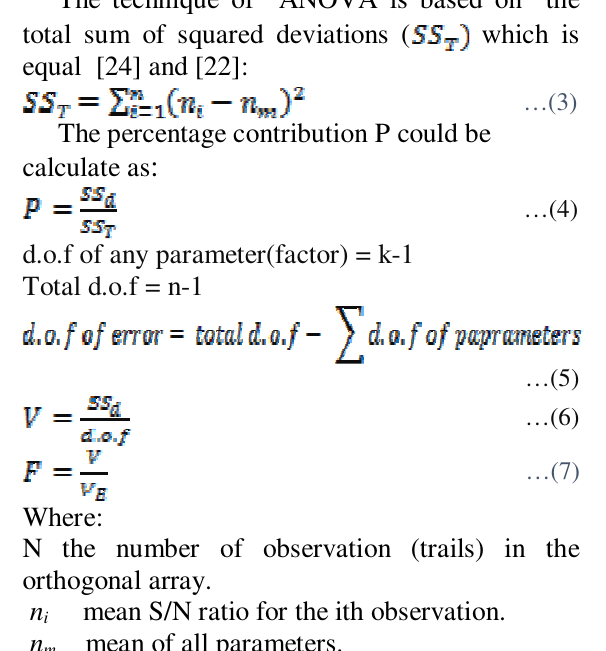
Fig. 1. The cylindrical thin wall structure